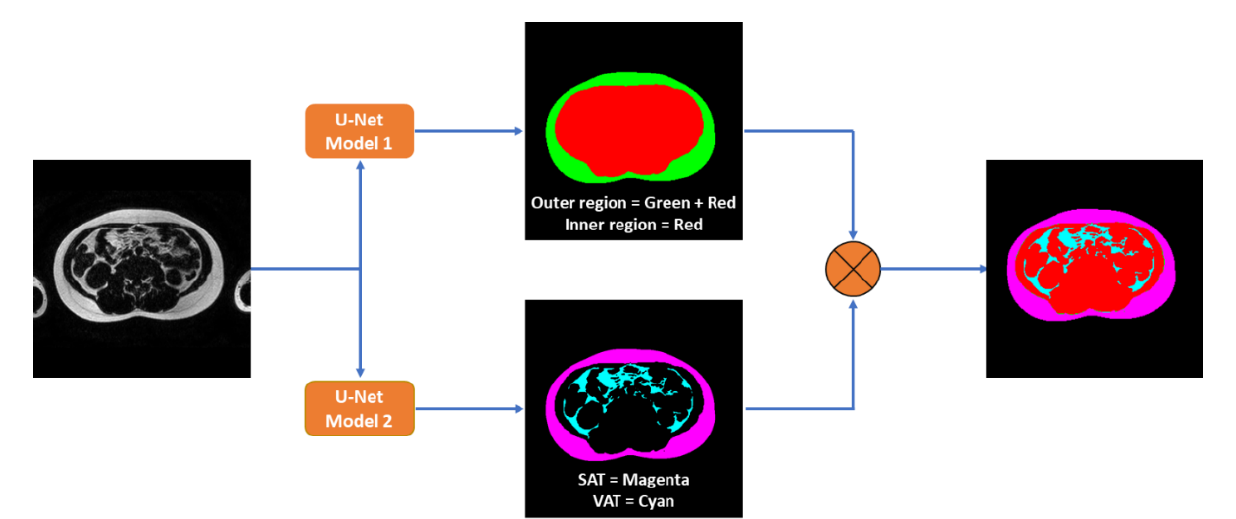
Figure 1. A standard U-Net architecture was used to train two models: one for outer and inner abdominal wall region segmentation, and one for subcutaneous (SAT) and visceral (VAT) adipose tissue pixel classification.